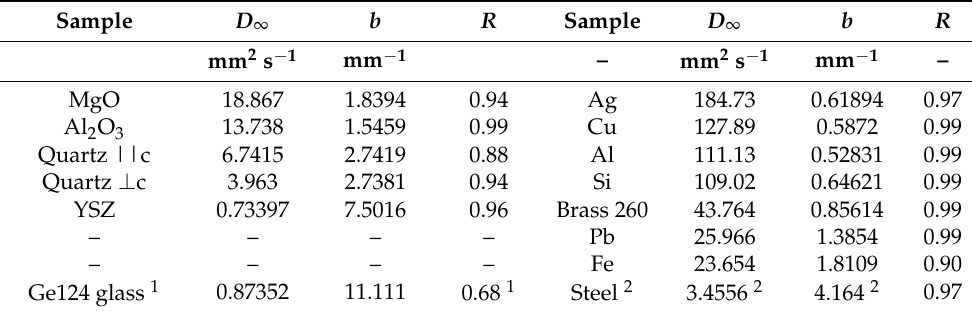
Table 2. Dependence of thermal diffusivity at 298 K on